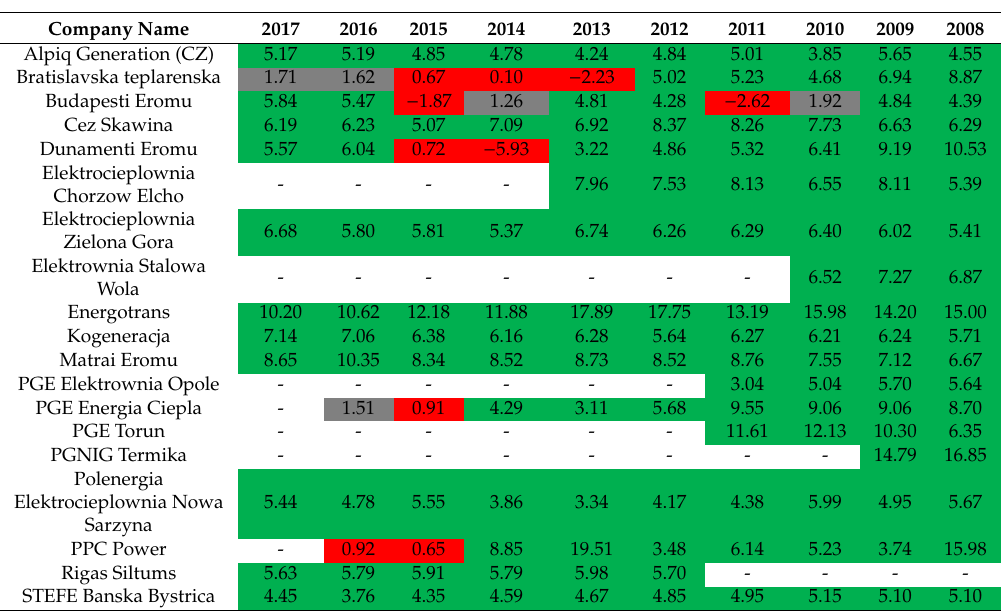
Table 5. Results of Altman model,